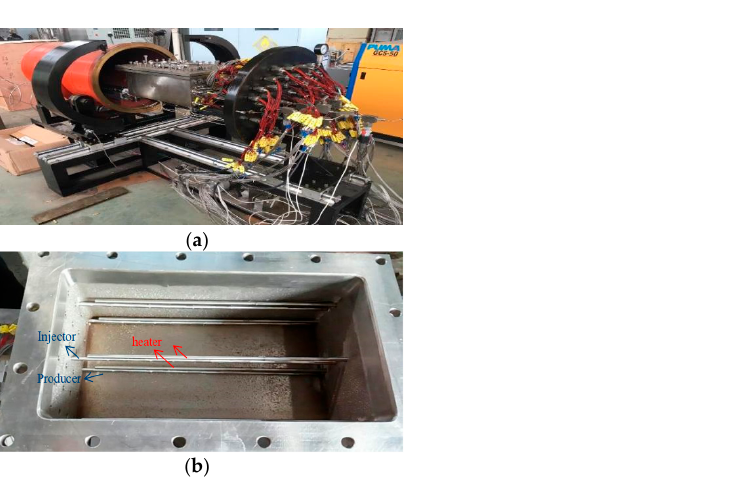
Figure 2. Experiment system with electrical heating and the well pair and heater deployment. ( a ) 3-D scaled experiment system. ( b ) Well pair and heater deployment.